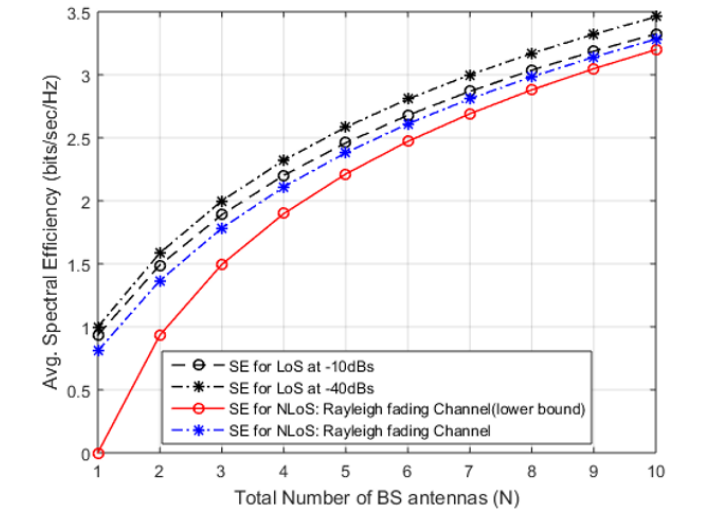
Figure 8. Desired signal, interference from other cell and noise added to the signal during transmission.